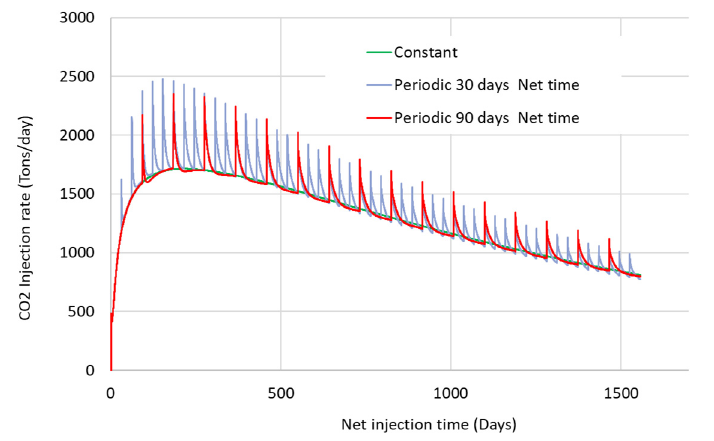
Figure 19. Net time rates of periodic injection vs. continuous injection rates for mid-reservoir injection—signaling lesser rate effects after each shut-in period.